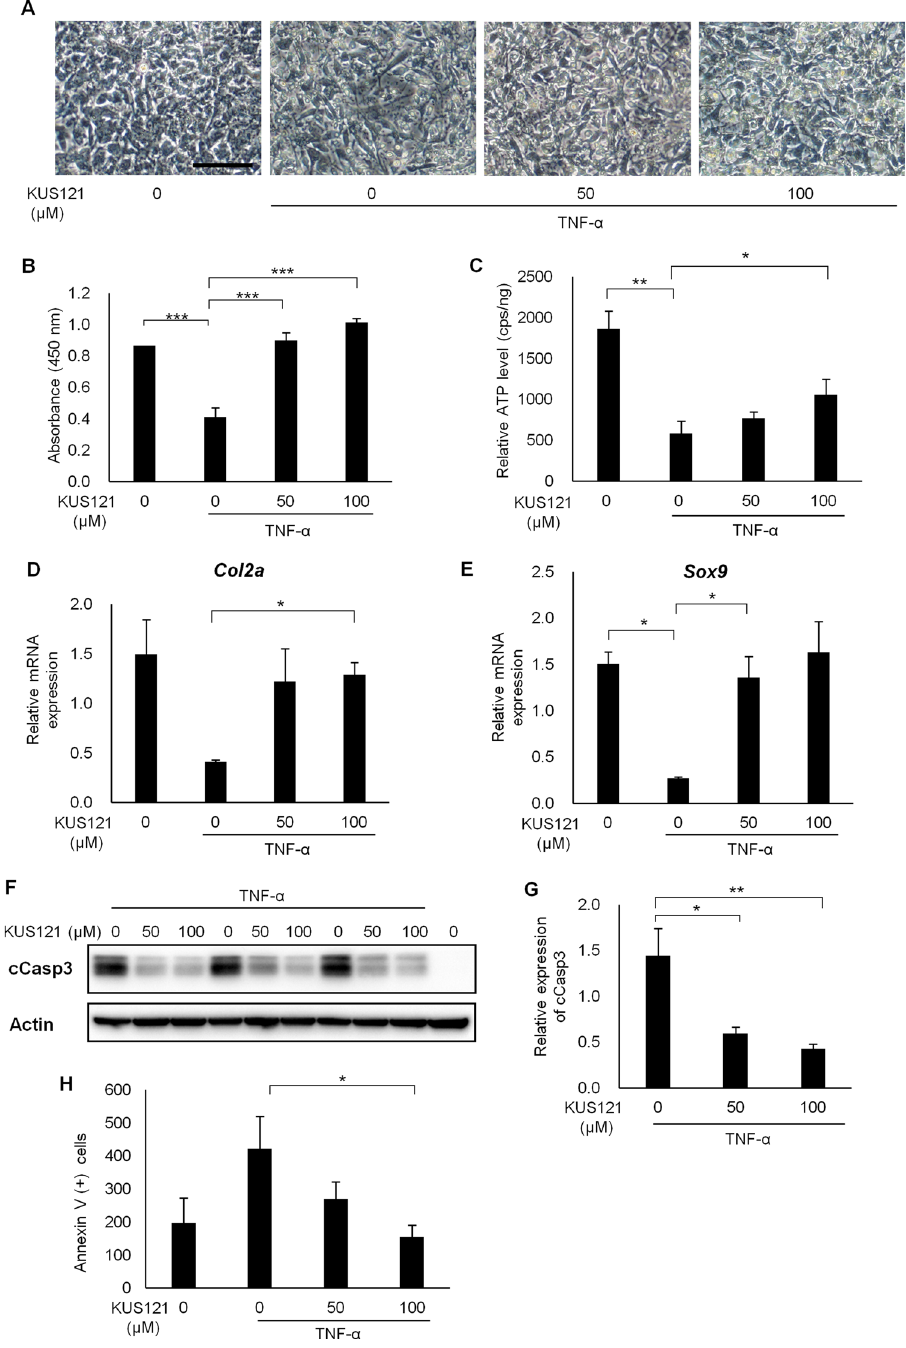
Figure 1. KUS121 suppresses TNF-α-induced cell death in differentiated ATDC5 cells. ( A – C ) Differentiated ATDC5 cells, cultured with tumor necrosis factor-alpha (TNF-α) (10 ng/mL) and KUS121 (0, 50 or 100 µM) for 48 h. ( A ) Brightfield images of the cells. Scale bar, 50 µm. ( B ) Water-soluble tetrazolium salt (WST) values, which reflect the relative live cell number, are shown as optical density at 450 nm. ***p < 0.001, vs TNF-α without KUS121, Dunnett T3 test, N = 6. ( C ) Intracellular ATP levels of the differentiated ATDC5 cells were measured with luciferase assays. The total protein content of cell lysate in each well was used for standardization. *p < 0.05, vs TNF-α without KUS121, Dunnett T3 test, N = 5. ( D , E ) Real-time PCR analysis of differentiated ATDC5 cells, treated with TNF-α (20 ng/mL) and KUS121 (0, 50 or 100 µM) for 24 h. mRNA expression levels of Col2a and Sox9 were normalized to Gapdh and relative expression levels are shown. *p < 0.05, vs TNF-α without KUS121, Dunnett T3, N = 3. ( F , G ) Western blot analysis of differentiated ATDC5 cells, treated with TNF-α (10 ng/mL) and KUS121 (0, 50 or 100 µM) for 48 h. Actin was used as a loading control. ( G ) The expression of cleaved caspase-3 (cCasp-3) was quantified and relative values were normalized to that of actin. Full-length blots are presented in Supplementary Fig. 2A. *p < 0.05 and **p < 0.01, vs TNF-α without KUS121, Dunnett T3 test, N = 3. ( H ) Differentiated ATDC5 cells cultured